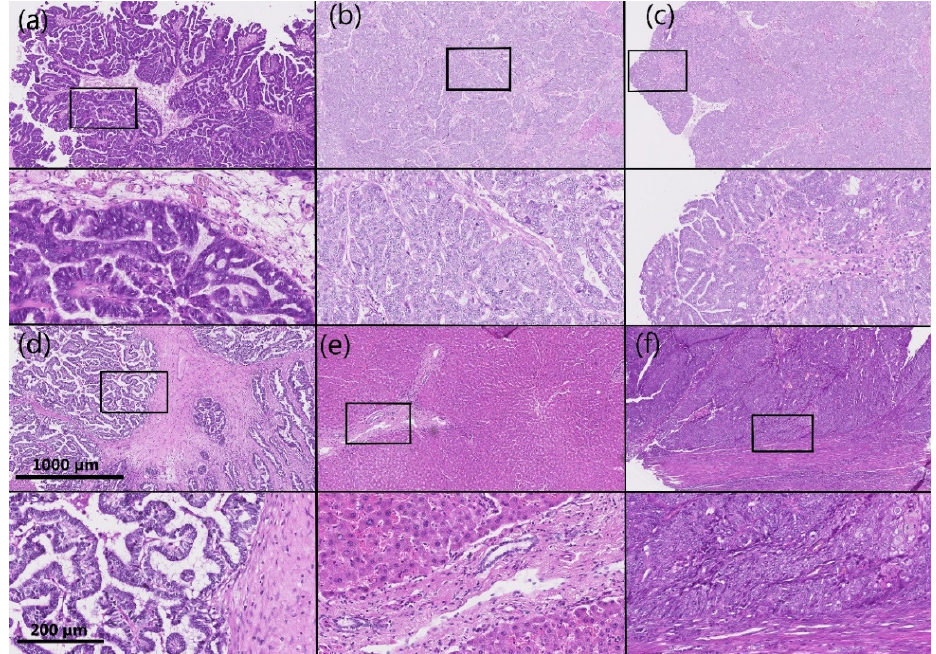
Figure 5. Representative hematoxylin and eosin staining of the same samples as shown in Figure 4. ( a – d ) HGSC; ( e ) control liver tissue; ( f ) control endometrioid endometrial cancer. Upper half of panels: 50 × magnification; lower half of panels: the framed area from the upper half of the panel (200 × magnification). HGSC: high-grade serous ovarian cancer.